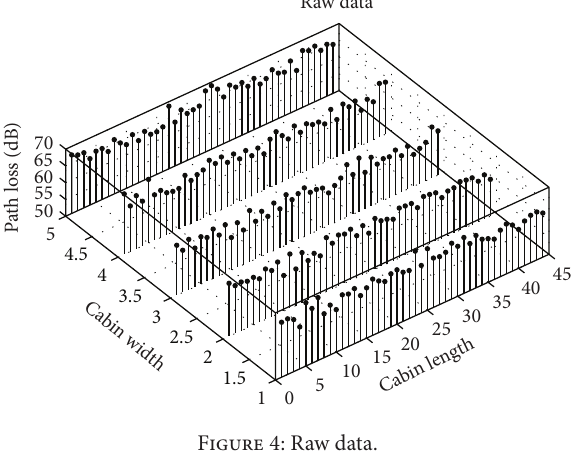
Figure 4: Raw data.